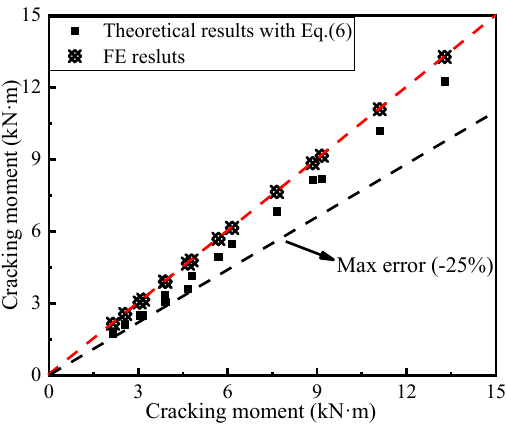
Figure 22. Comparison of the cracking moments calculated by the theoretical and the FE methods. According to the technical specification for application of autoclaved aerated con- crete [19], the flexural stiffness B s of an AACP is expressed by Equation (8)